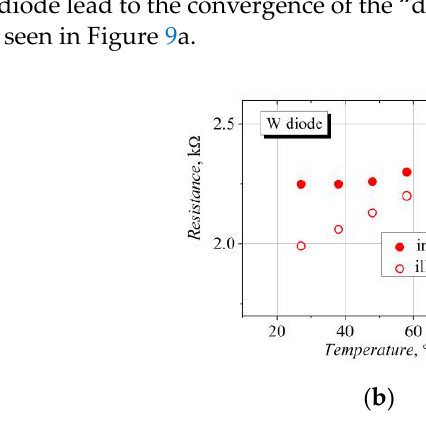
Figure 9. Temperature dependence of voltage sensitivity ( a ) and electrical resistance ( b ) of the bow-tie diodes on the base of a selectively doped InAlAs/InGaAs semiconductor structure with InAs inserts in the dark and under 14,400 lx illumination.